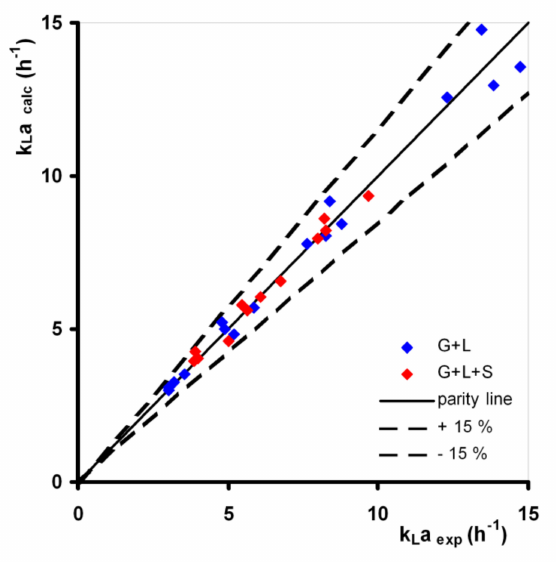
Figure 11. Overall volumetric mass transfer coefficient k L a : Comparison of experimental and calcu- lated data using (13)—parity